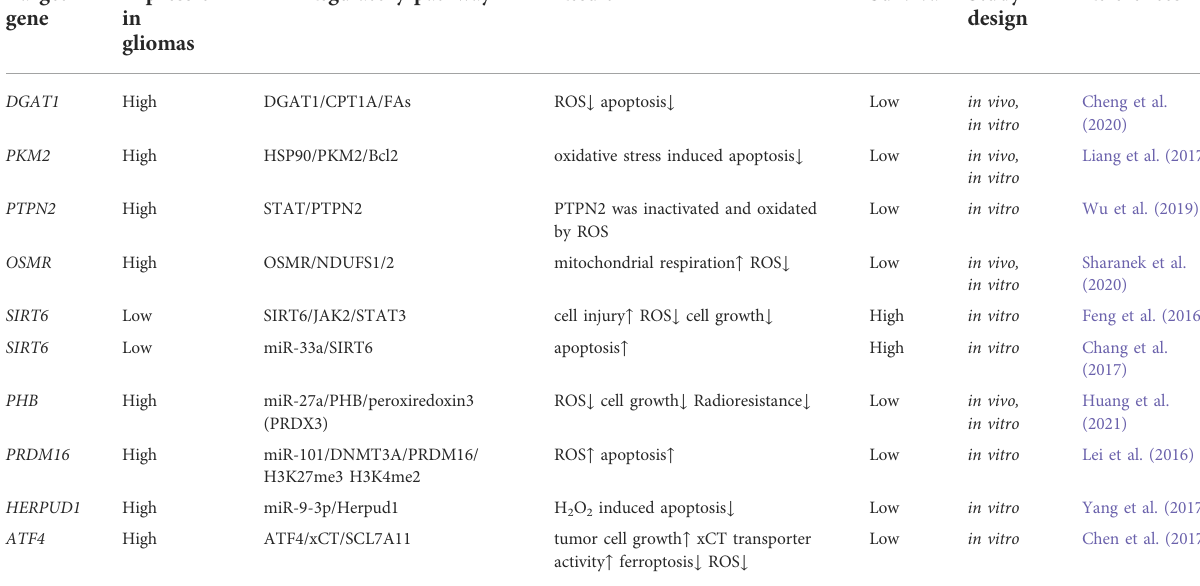
TABLE 1 Summary of studies on target genes linked to ROS in gliomas. Target